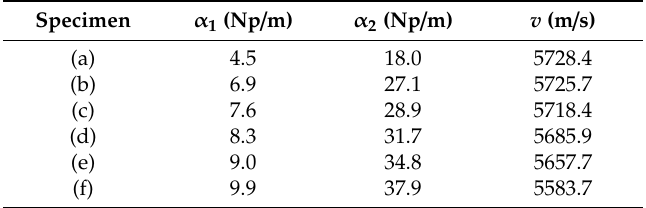
Table 2. Wave velocity and attenuation results in different specimens.